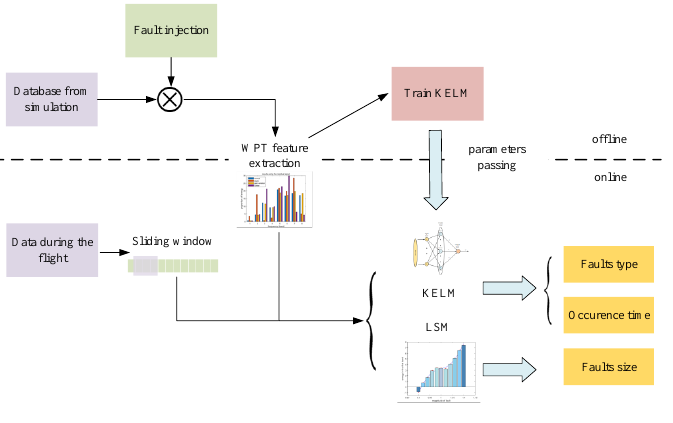
Figure 1. Flowchart of the